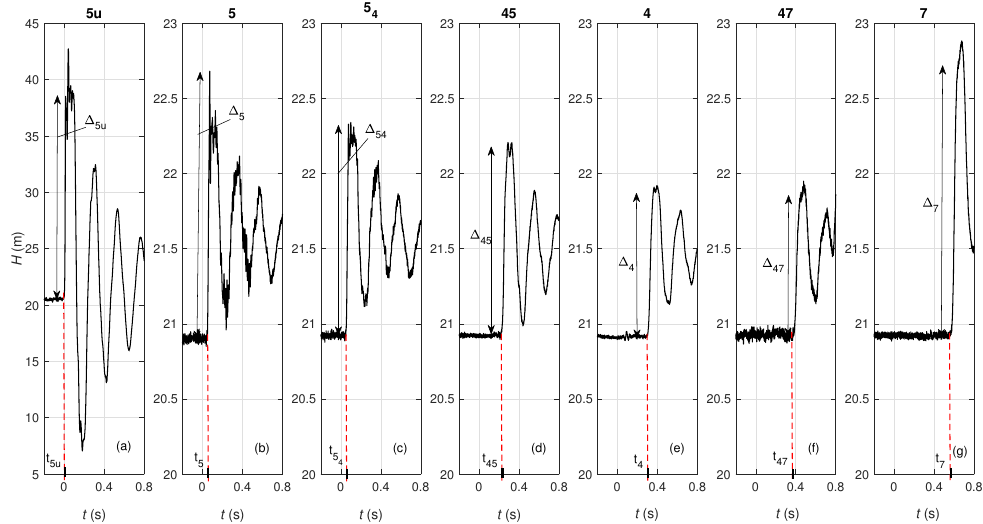
Figure 4. Test #1—one of the paths of the generated pressure wave of Figure 3 in the network— pressure signals at measurement sections: ( a ) 5u; ( b ) 5; ( c ) 5 4 ; ( d ) 45; ( e ) 4; ( f ) 47; and ( g ) 7.